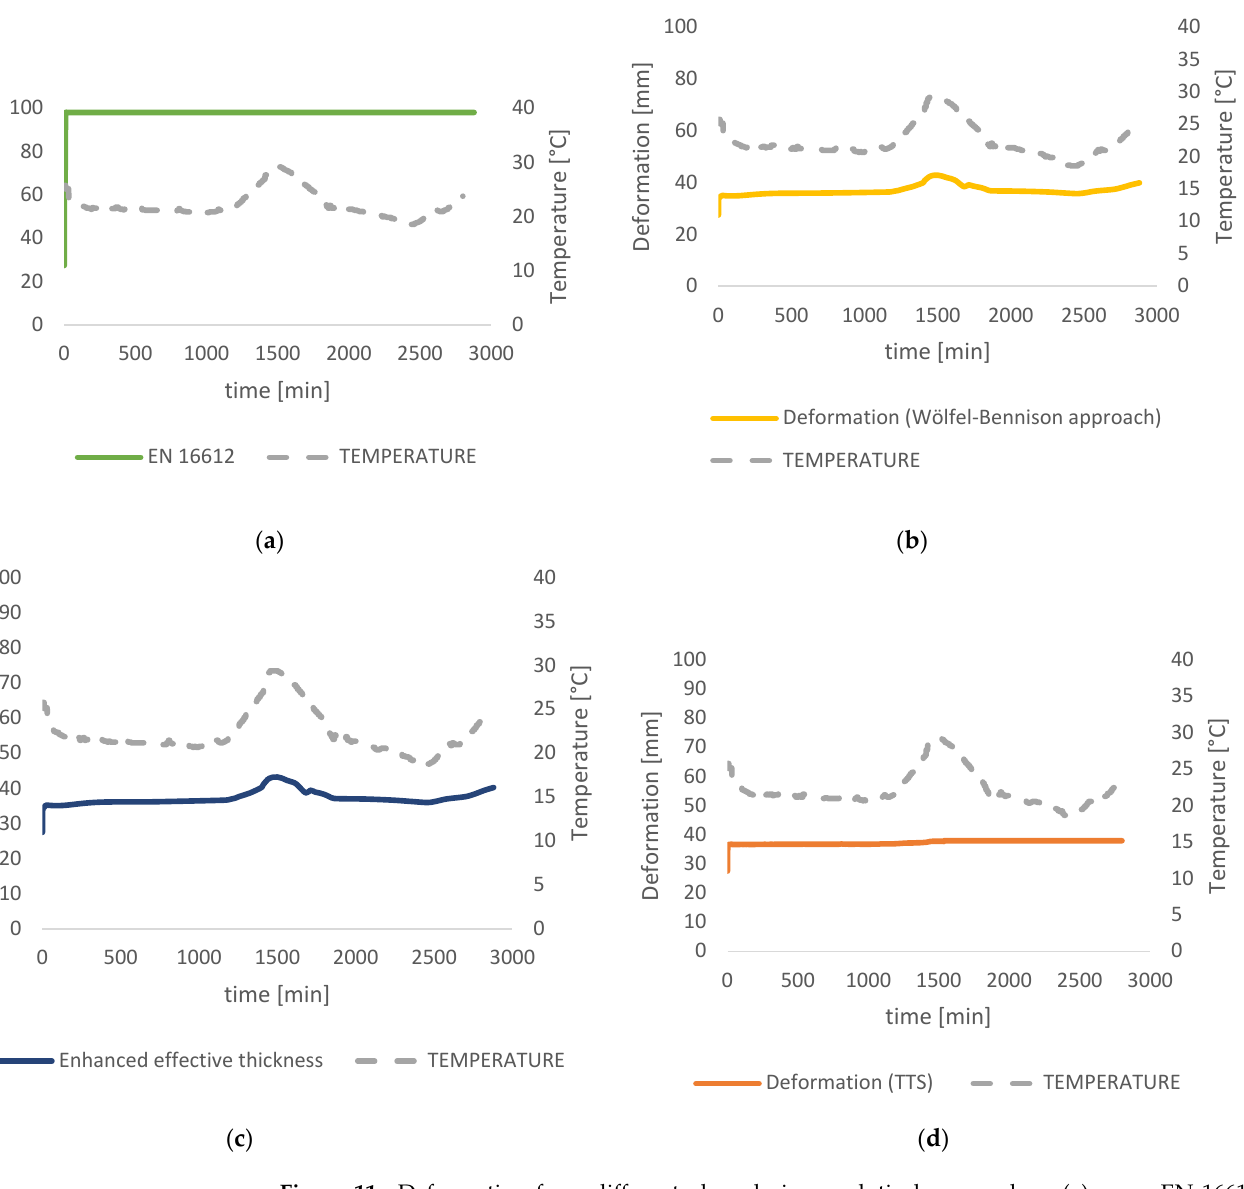
Figure 11. Deformation from different glass design analytical approaches: ( a ) norm EN 16612; ( b ) Wölfel-Bennison approach; ( c ) Enhanced effective thickness approach; ( d ) Effective thickness approach combined with TTS correction of Shear Modulus G.